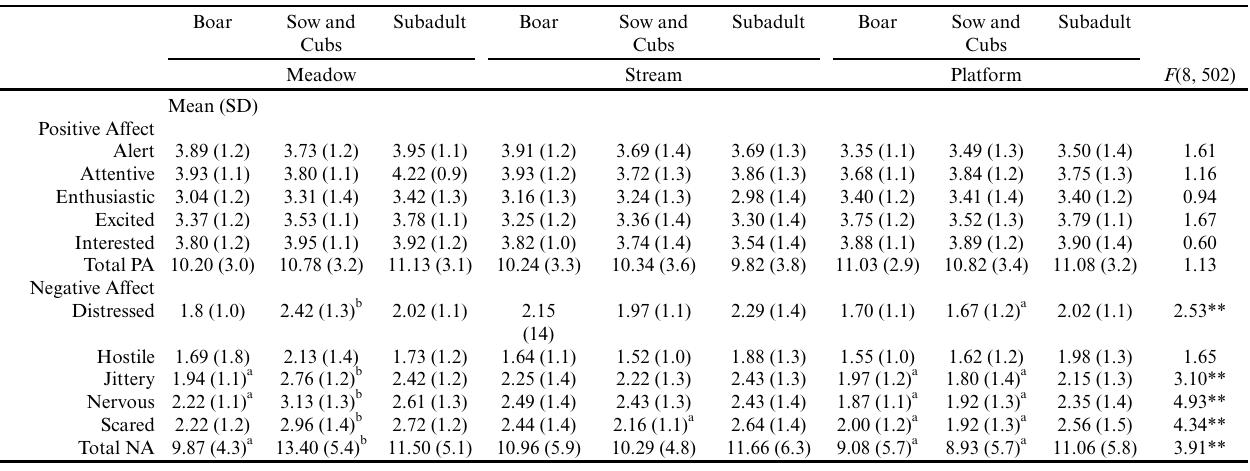
Table 1 . Mean intensity of affective response to the nine setting treatments. Note: Intensity was ranked by respondents on a five-point scale with 1 representing “very slightly or not at all” and 5 representing “extremely.” Superscripts represent significant differences across rows at the p < 0.05 level. Total PA does not include alert or attentive. *p < 0.05 **p < 0.01 Boar Sow and Subadult Boar Sow and Subadult Boar Sow and Subadult Cubs Cubs Cubs Meadow Stream Platform F (8,